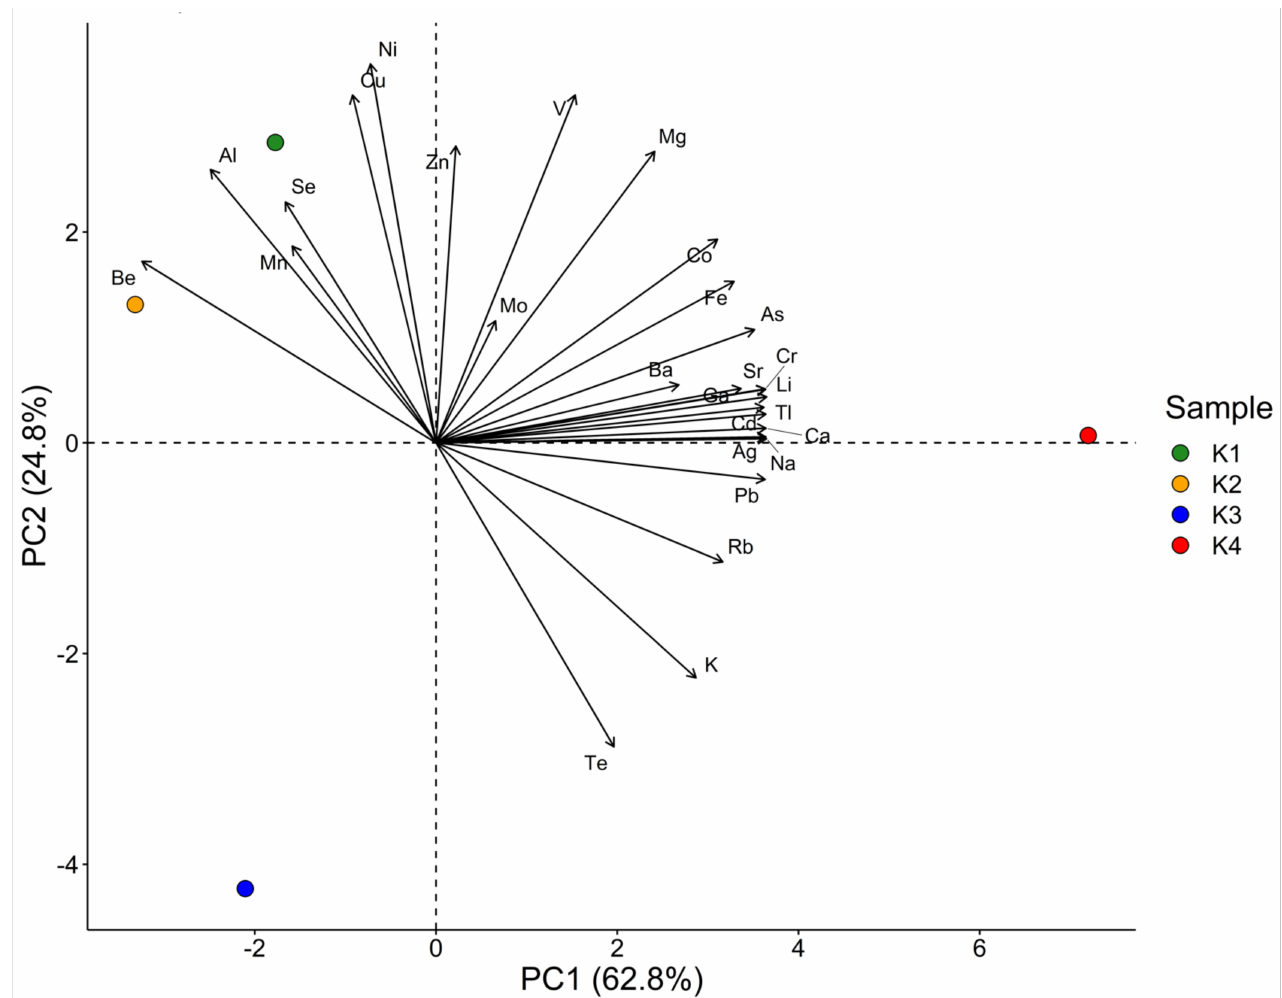
Figure 3. PCA-Biplot for the four turmeric samples considering all